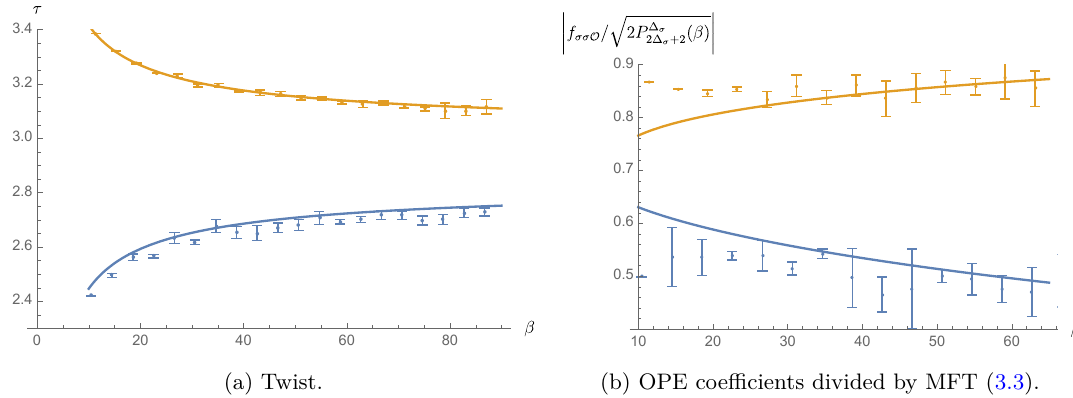
Figure 25 . Same as figure 24 but for the [ σσ ] 1 and [ (cid:15)(cid:15) ] 0 families (top and bottom, respectively). so dDisc G is a positive-definite distribution. Consider first the integration region where z (cid:28) ¯ z (cid:28) 1 . In this region, the block in eq. (2.11) has an exponential-like dependence